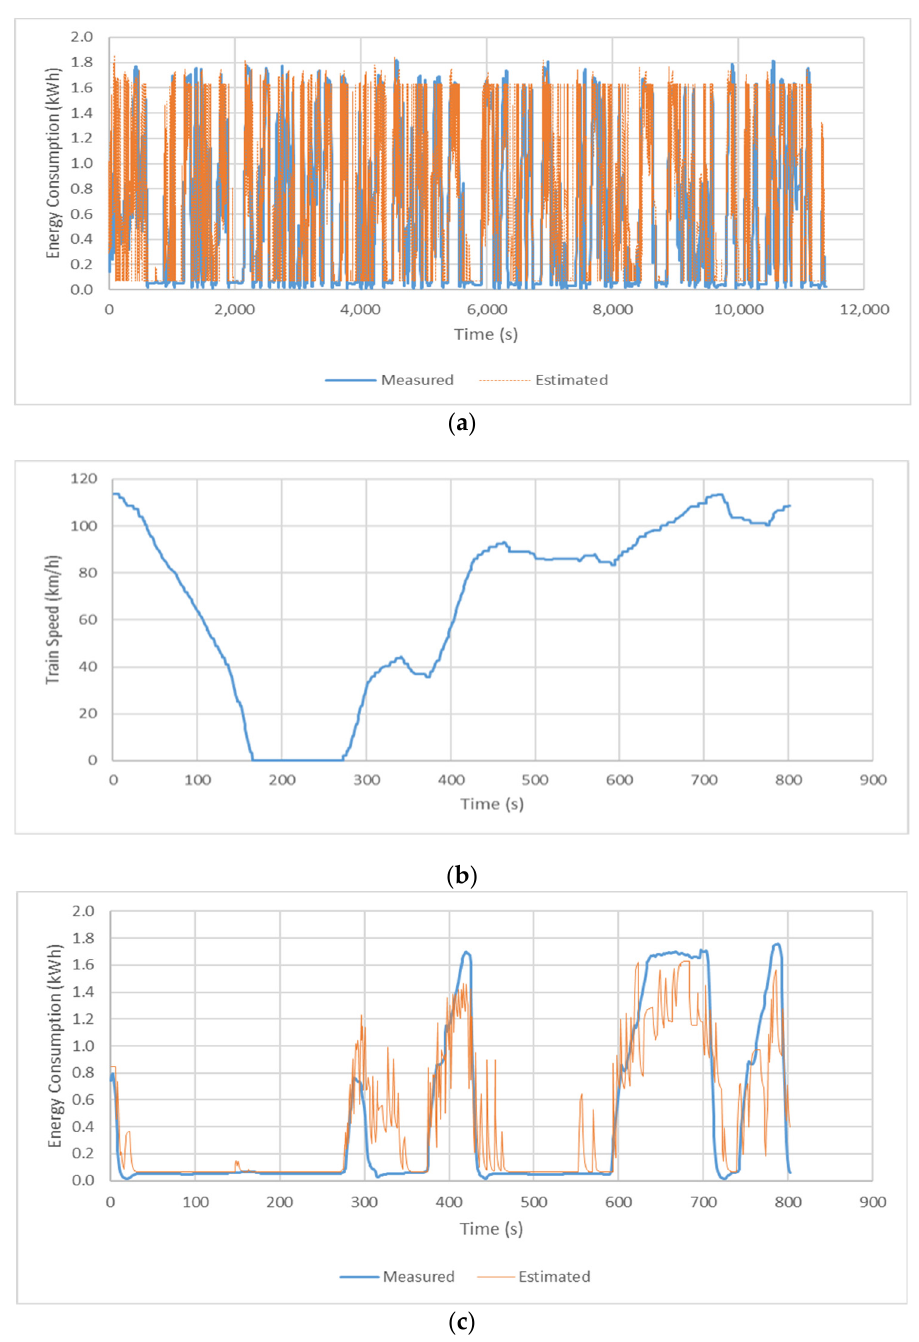
Figure 6. Model estimation: ( a ) energy estimation for a sample Train 1 trip, ( b ) speed profile of a sec ‐ tion between two stations (Cary to Durham), ( c ) energy estimation of a section between two stations (Cary to Durham).